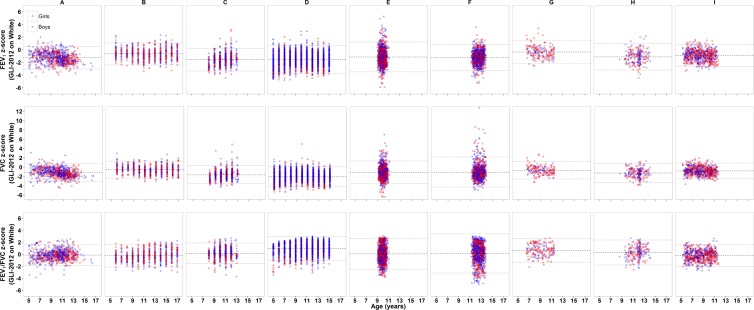
Distribution of lung function data (based on GLI-White) vs. age according to centre.Symbols: Blue denotes data from boys and Red denotes data from girls. Dashed line = mean value and dotted lines 95% limits of agreement (Mean ± 2 SD) for each dataset. Centres: A = Bangalore; B = Delhi; C = Gujarat; D = Hyderabad; E = CHASE (London); F = DASH (London); G = Leicester City; H = LRC (Leicester); I = SLIC (London). Note the different scales used on the y-axis reflecting the greater spread of FVC than FEV1 data. Note: Age was only recorded to the nearest year for data from Centres B, C and D.